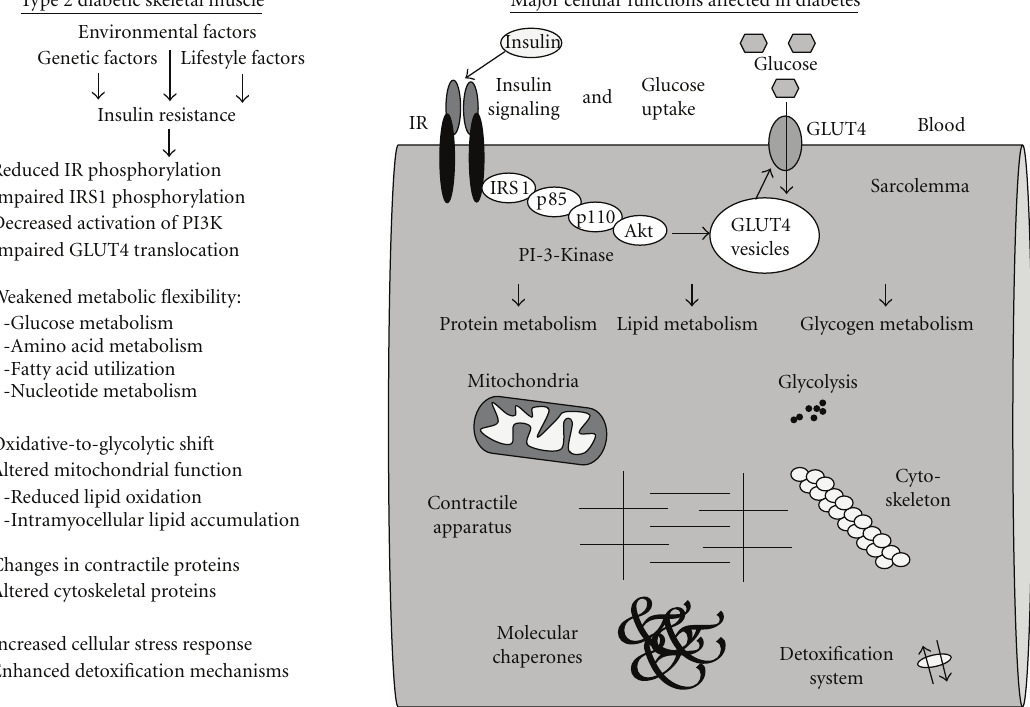
Figure 2: Overview of changes in diabetic skeletal muscle as revealed by mass-spectrometry-based proteomics. Shown is a diagram of a skeletal muscle fibre outlining sarcolemmal proteins involved in insulin signaling and glucose uptake, as well as major cellular mechanisms a ff ected in diabetic muscle tissues. Listed are established diabetes-related impairments of insulin receptor (IR) phosphorylation and abnormal signaling and transporter recruitment involving IRS1, p85, p110, Akt, PI-3-kinase, and glucose transporter isoform GLUT4. Proteomic profiling of muscle tissues from patients and established animal models of type 2 diabetes have revealed changes in components downstream from these plasmalemmal signaling cascades, including proteins involved in mitochondrial metabolism, glycolysis, contractile apparatus, detoxification mechanisms, cellular stress response, glucose metabolism, fatty acid utilization, nucleotide metabolism, and amino acid